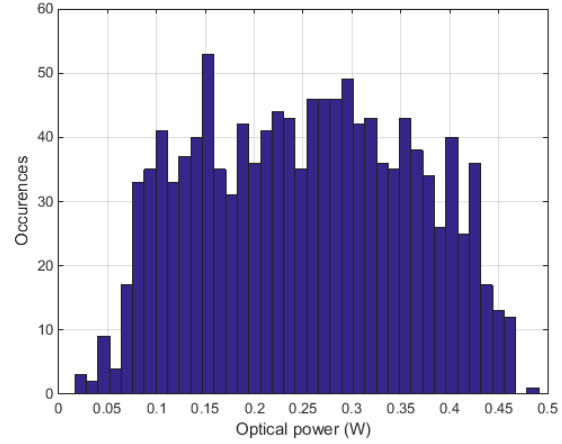
Figure 3. Number of occurrences of the optical–parametric oscillator output power between 3.2 µm and 3.5 µm.